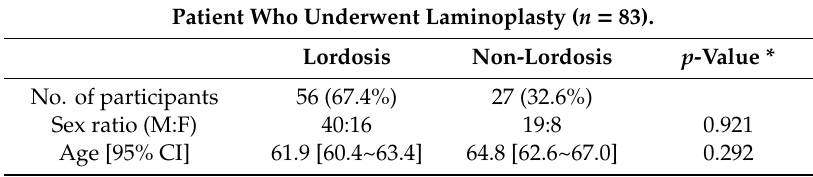
Table 2. Demographic data of the study